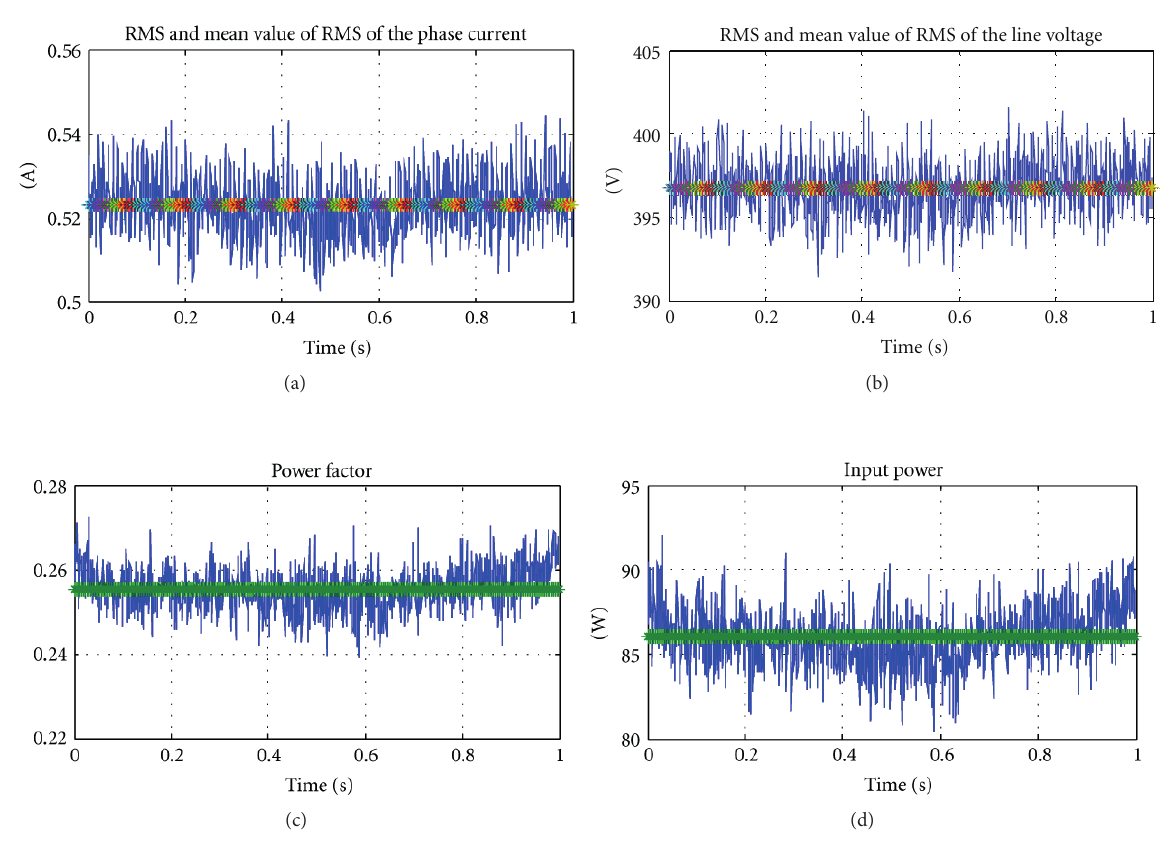
F 12: Experimental results of the stator current/voltage RMS value, power factor, and input power during 1